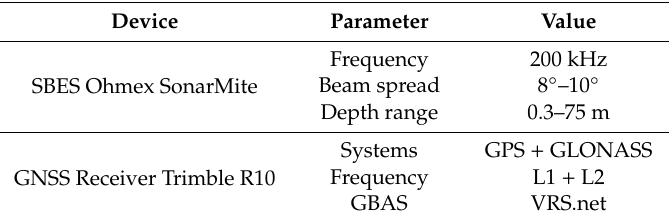
Table 3. Basic parameters of the elements of the hydrographic